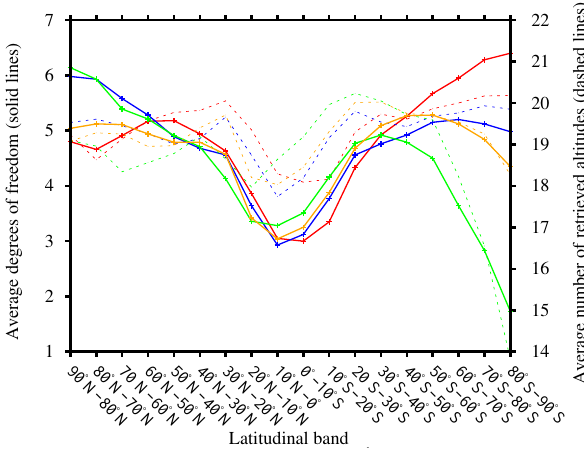
Figure 4. Average phosgene degrees of freedom (DOF, solid lines) and average of retrieved altitudes (dashed lines) for DJF (red), MAM (blue), JJA (green) and SON (orange). Averages are calcu- lated for 10 ◦ latitude bins.